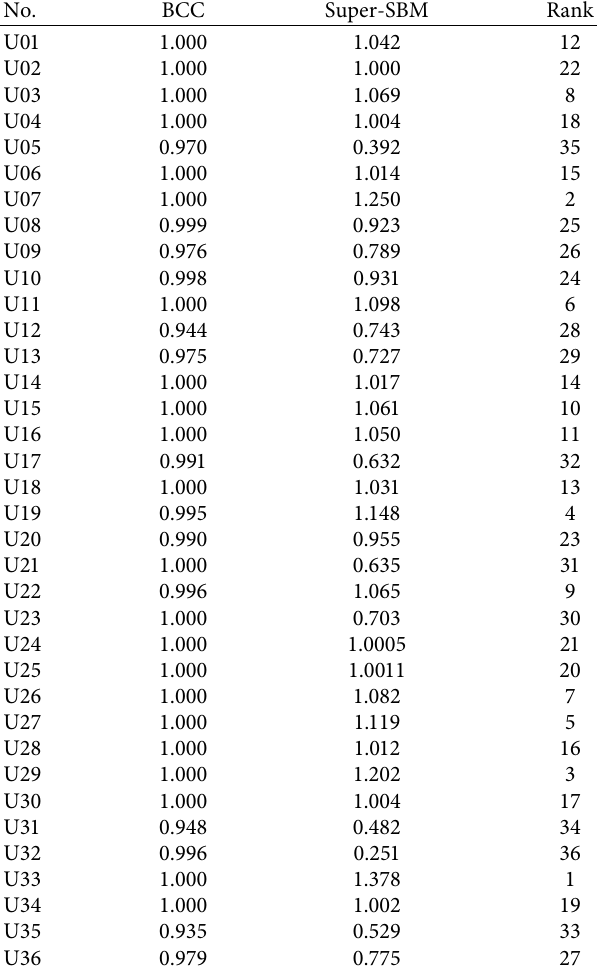
Table 5: Teaching efficiency and projection values of 36 “Double First-Class” universities.